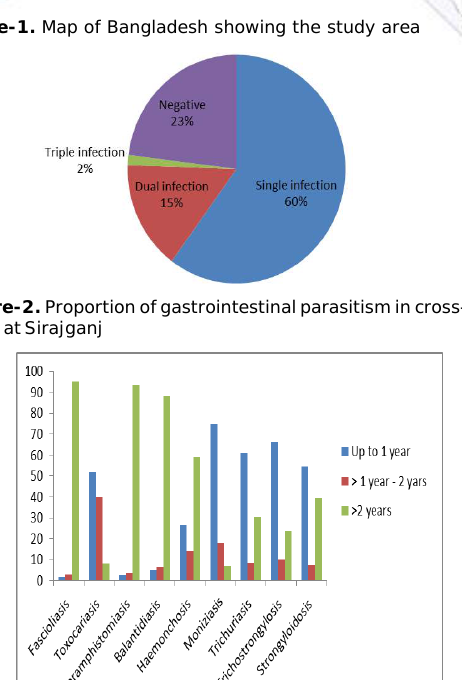
Figure-1. Map of Bangladesh showing the study area